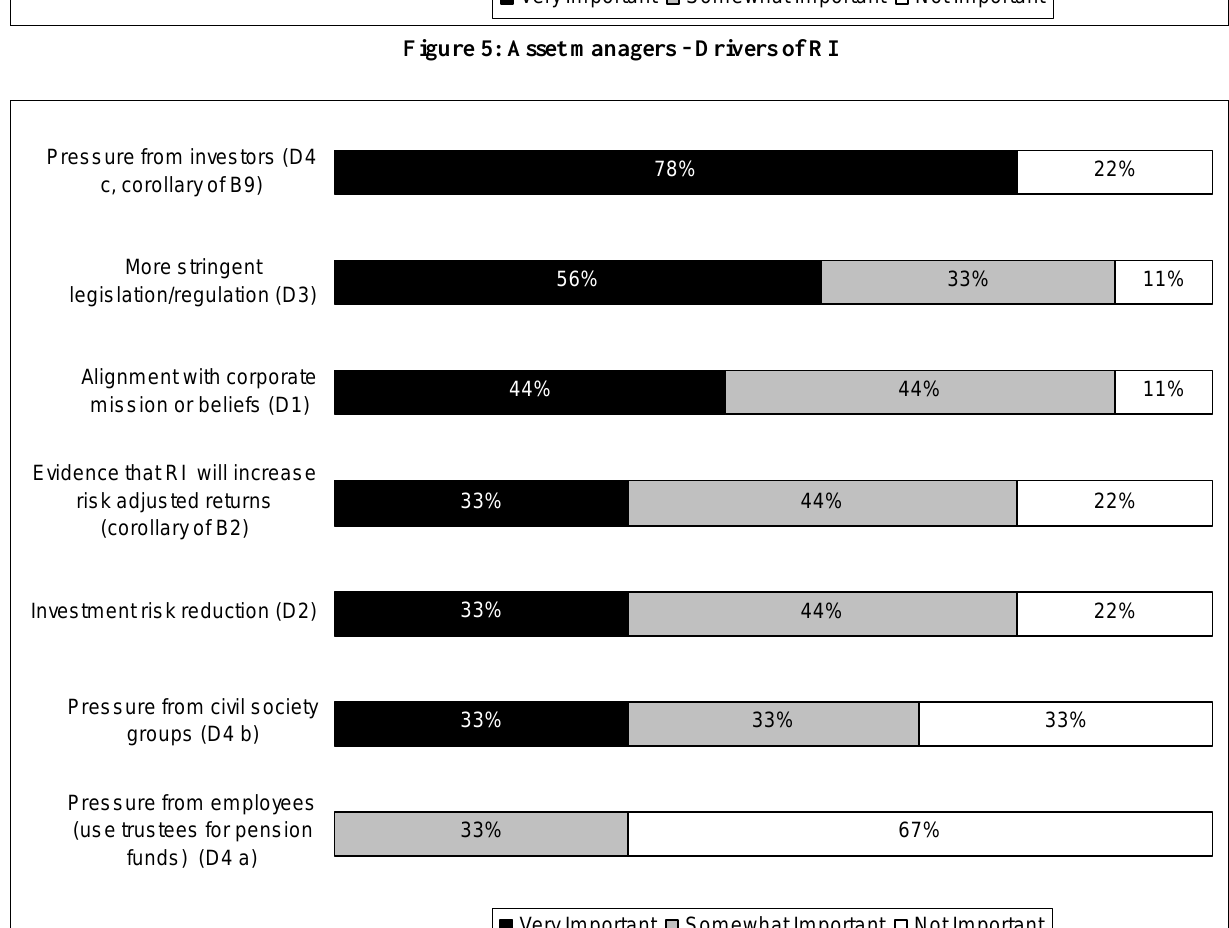
Figure 6: Advisory service providers - Drivers of